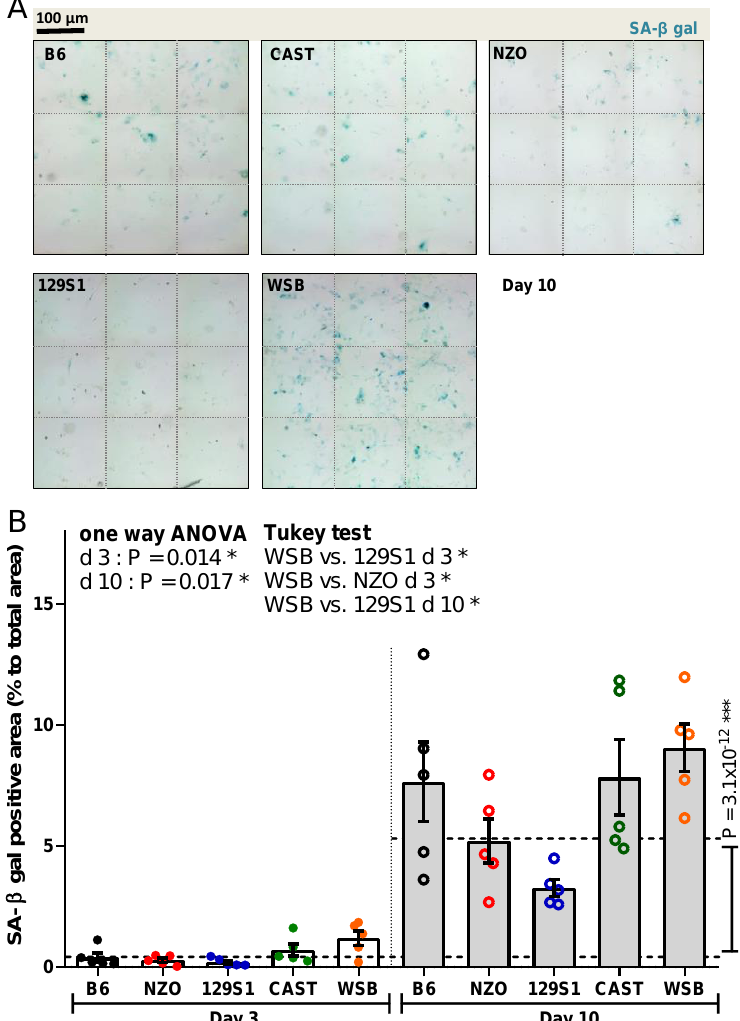
Figure 2. Analysis of cellular senescence using senescence-associated beta-galactosidase (SA- β -gal). ( A ) Representative images of PTEC after SA- β -gal staining (positive cells are blue) at day 10 after irradiation. Original magnification 200 × . ( B ) Quantification of SA- β -gal staining of PTEC at days 3 and 10 after irradiation. Results are presented as means ± SEM ( n = 5 mice for each strain). Significance between means of strains and means of time points were tested by the one-way ANOVA and t- test, respectively. Tukey’s test was performed as a post-hoc analysis in the case of multiple comparisons. Results from days 3 and 10 are tested separately. * p < 0.05; *** p < 0.001.